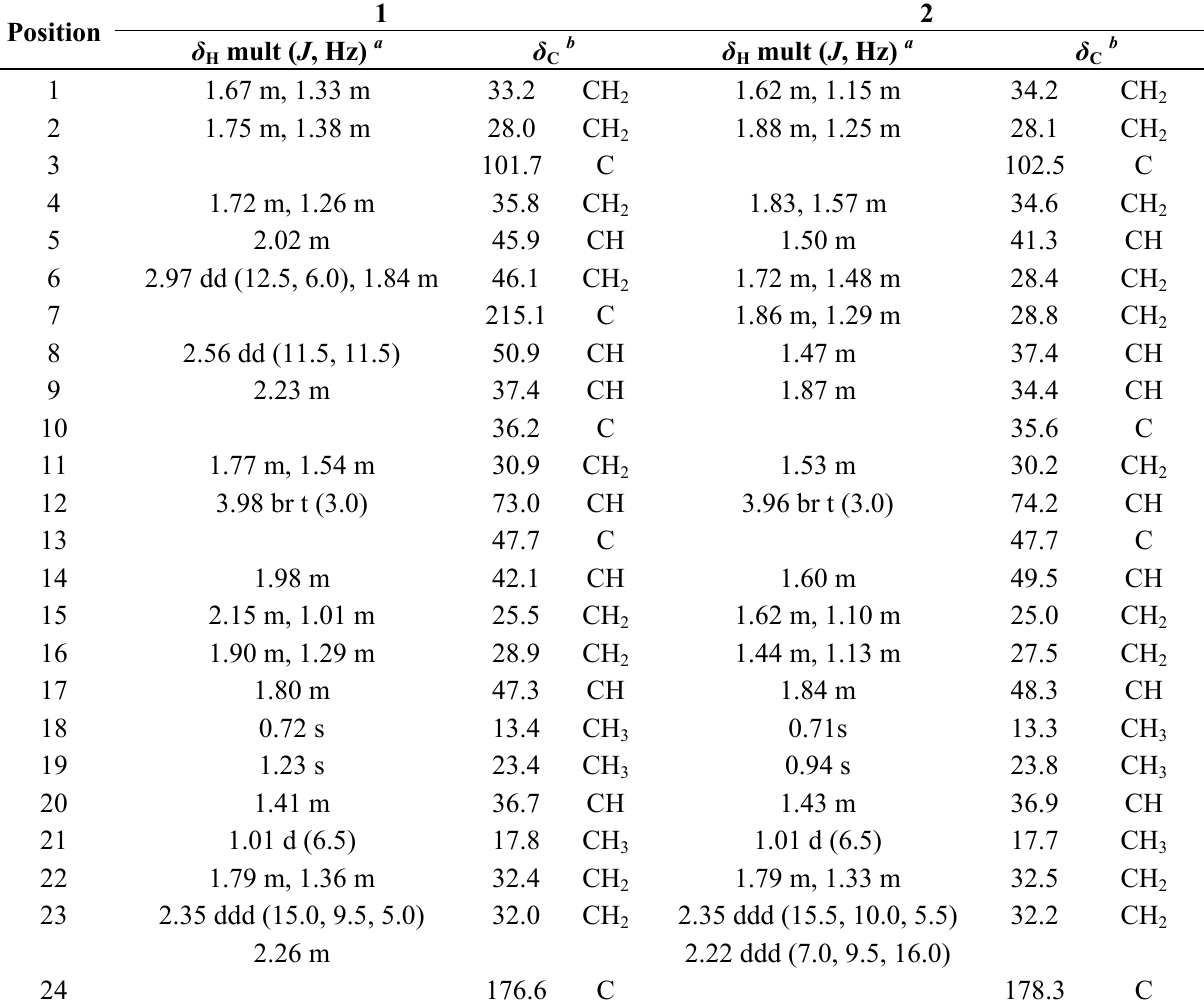
Table 1. 1 H and 13 C-NMR spectral data for compounds 1 and 2 in methanol- d